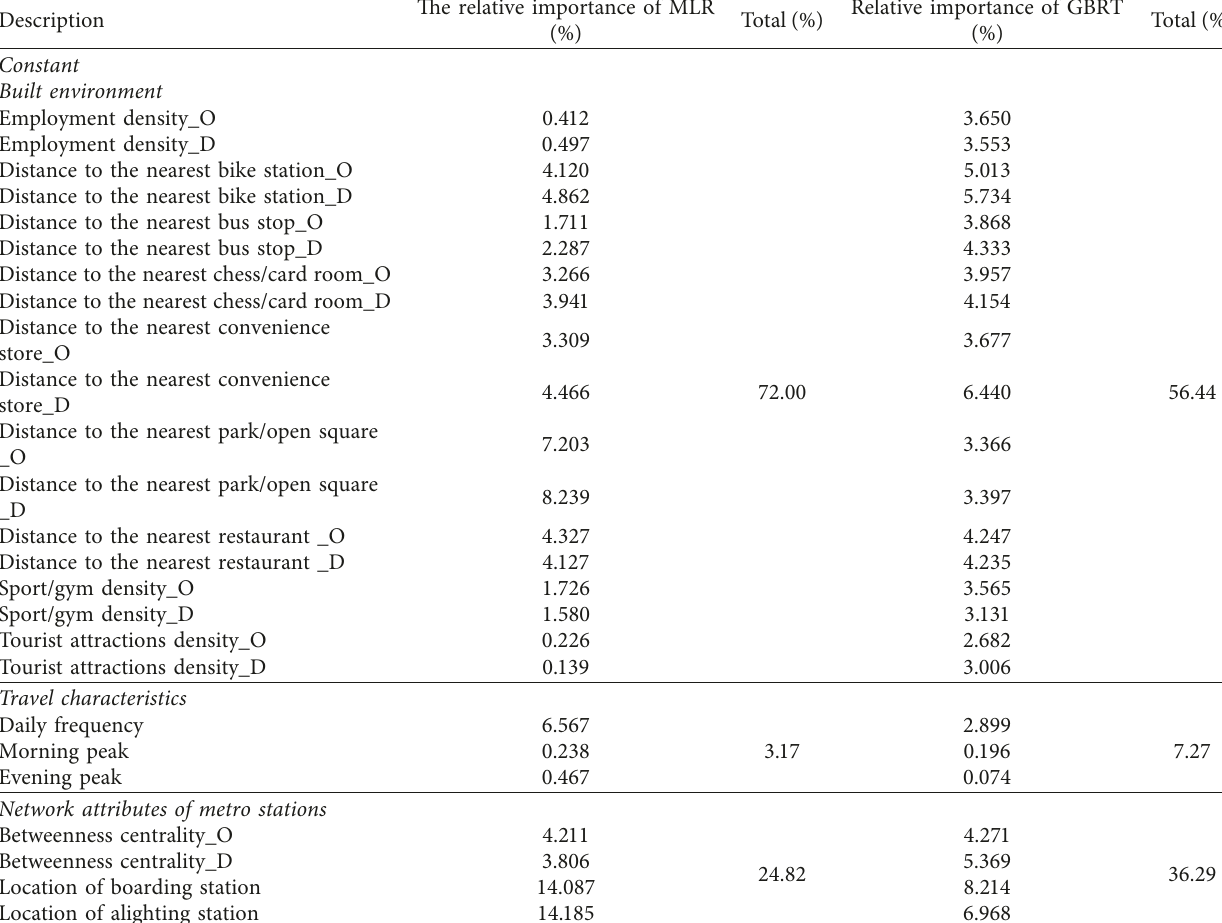
Table 5: Relative importance of all the